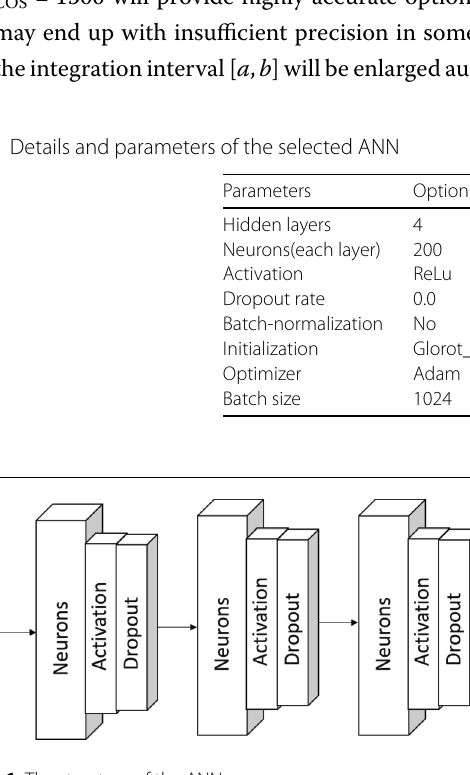
Figure 6 The structure of the